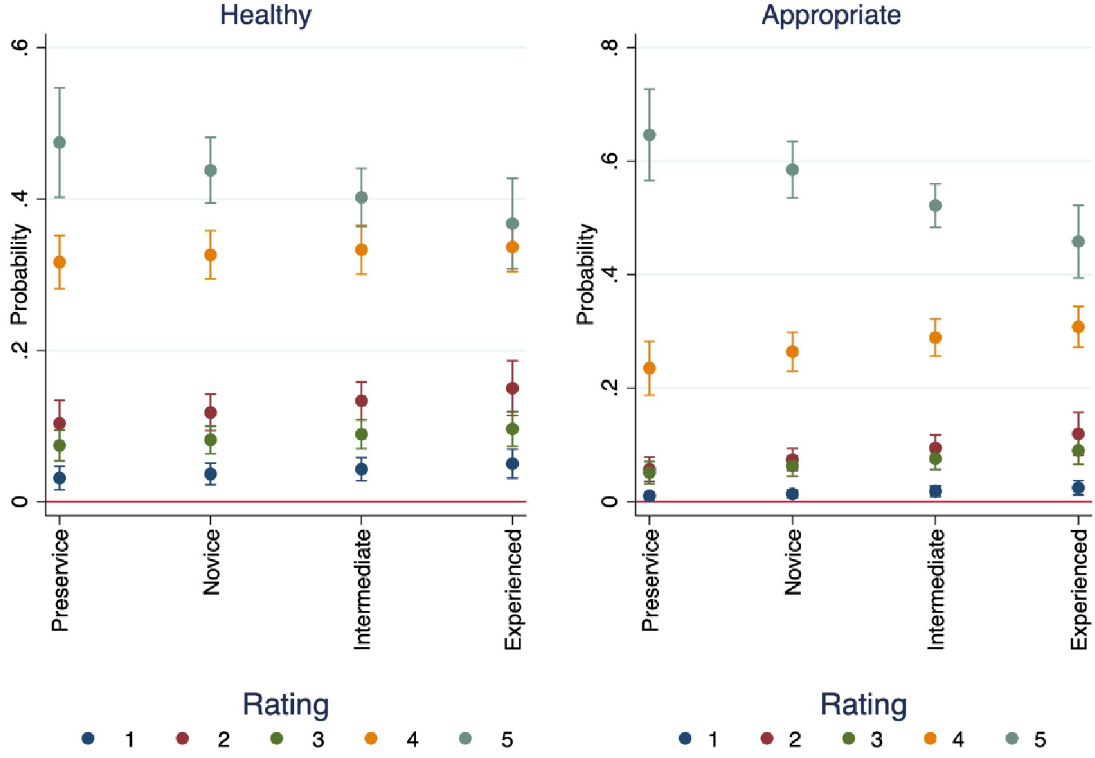
Fig 1. Marginal effects of years’ experience on probability of rating audio samples as healthy and